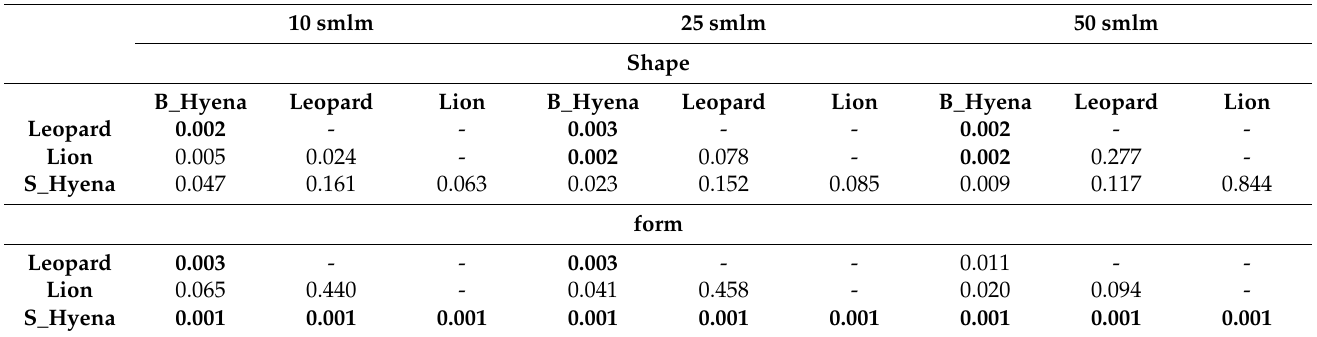
Table 4. MANOVA p -values obtained on the 10, 25, and 50 semilandmark (smlm) models used to describe the cross-sections at 50% of the score length. Statistical significance ( p < 0.003) is marked in